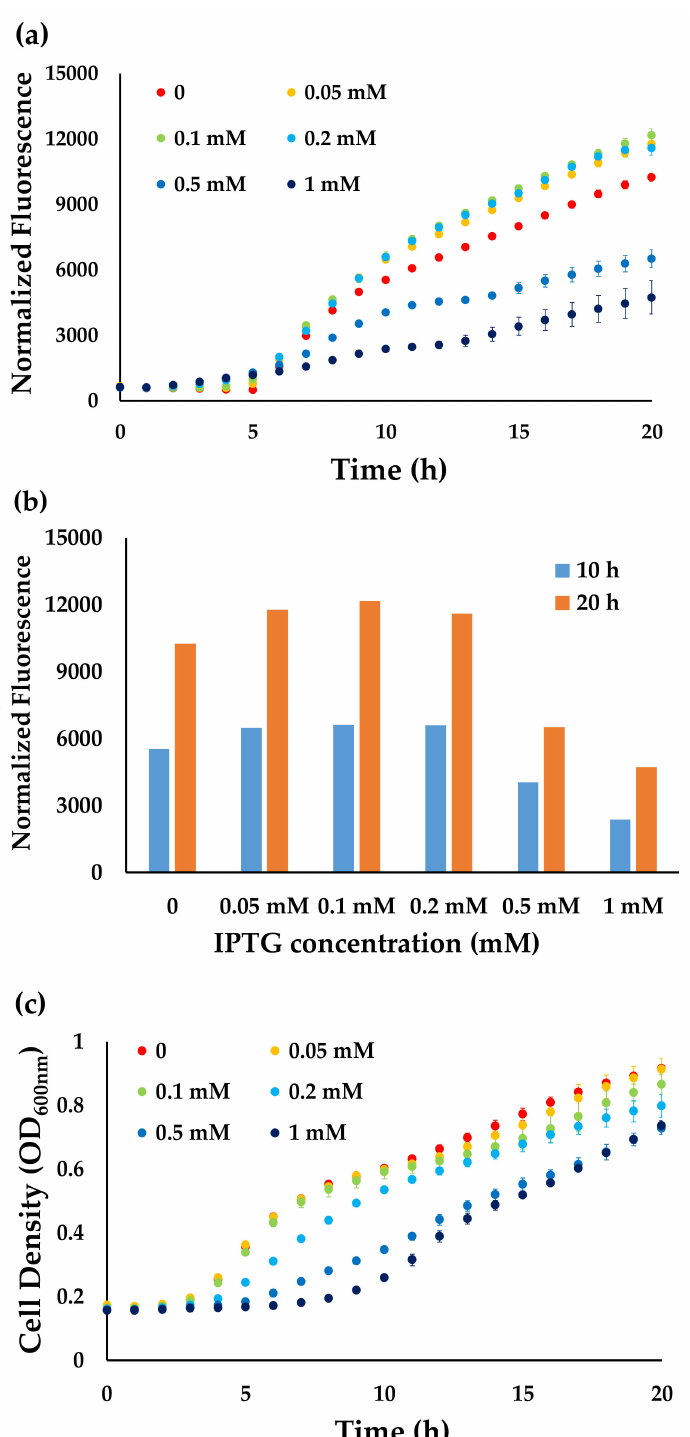
Figure 1. The effects of isopropyl β - D -1-thiogalactopyranoside (IPTG) concentrations on green fluorescent protein (GFP) expression and cell growth. ( a ) The normalized fluorescence intensity was used for determining protein production, which was the absolute fluorescent intensity subtracted with the fluorescence background of AG1 cells in the same growth condition over the cell density (OD 600nm ); ( b ) The effects of IPTG concentrations on the normalized fluorescence intensity at 10 h and 20 h after inoculation; ( c ) The cell density was used for determining cell growth. The mean values and standard deviations were calculated from three biological